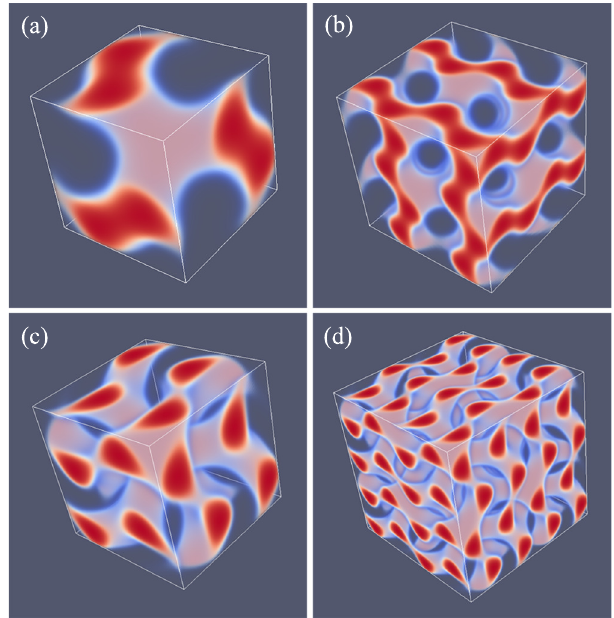
Figure 4. ( a ) SF-SCF predictions for the volume fraction profiles of a SG unit cell for D = 43, N = 300, χ N = 30 and f = 0.33; ( b ) eight unit cells of a SG (result of ( a ) is doubled in each direction); ( c ) volume fraction profiles of a DG unit cell for D = 74, N = 300, χ N = 30 and f = 0.34; ( d ) eight unit cells